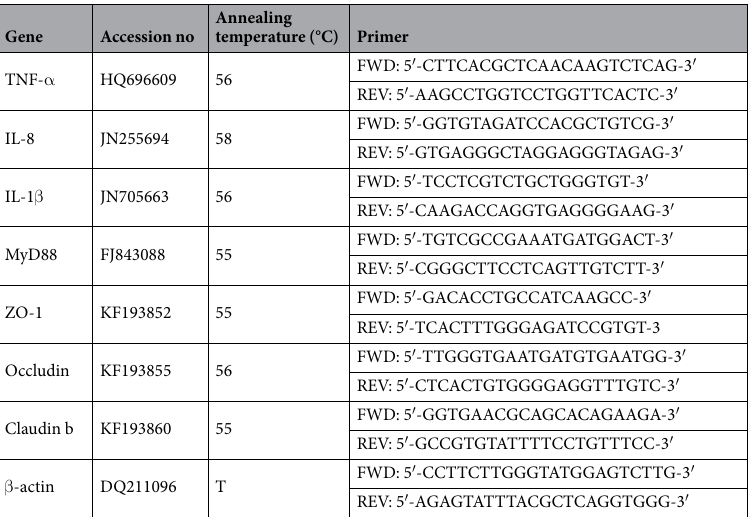
Table 3. List of primers for real-time quantitative PCR amplifications 1 . 1 TNF- α : tumor necrosis factor a; IL: interleukin; MyD88: myeloid differentiation factor 88; ZO-1: zonula occludens-1. T: 56, 58 or 55